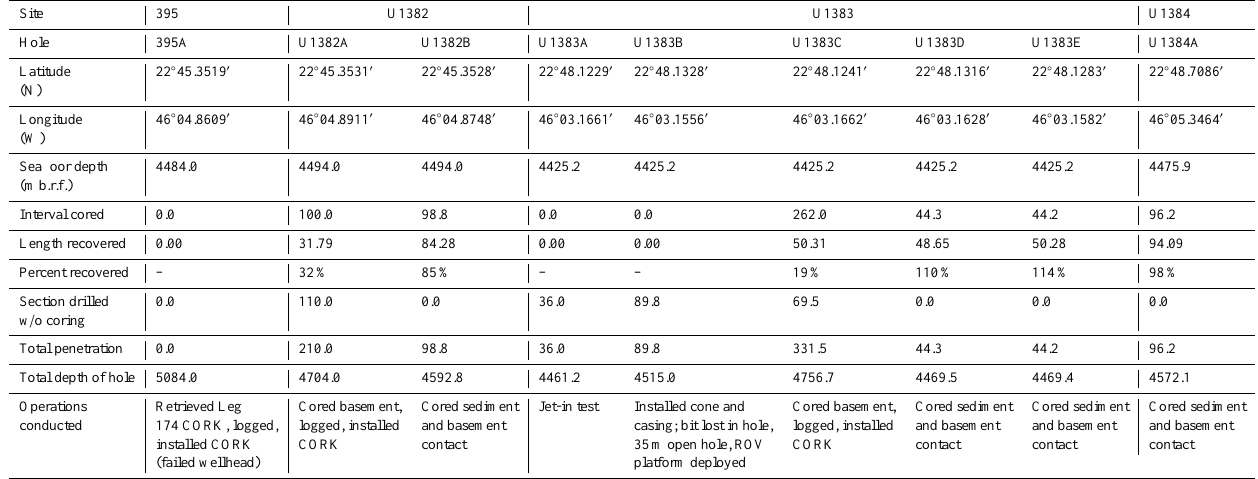
Table 1. Overview of operational